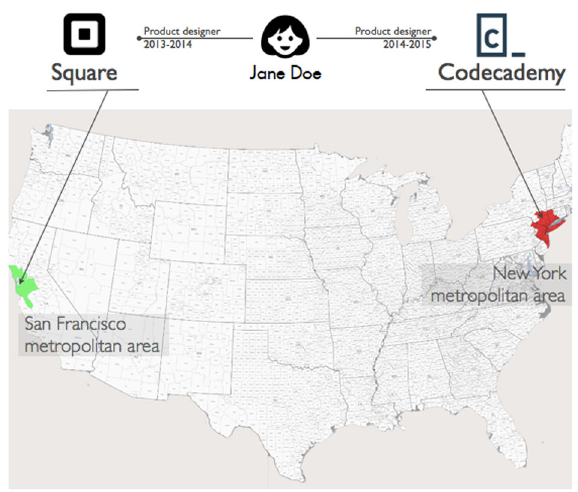
Fig. 2 Example of how the Workforce Mobility Network (WMN) is built. Its nodes represent metropolitan statistical areas (MSA) in the United States, while each of its directed links has a weight equal to the number of employees who worked in one area and then moved to another area. For instance, Jane Doe, who moved from Square Inc. in the San Francisco area (green) to Codecademy in the New York area (red), acted as a bridge between the two companies and contributed to increase the weight of the directed link from the San Francisco area to the New York area by